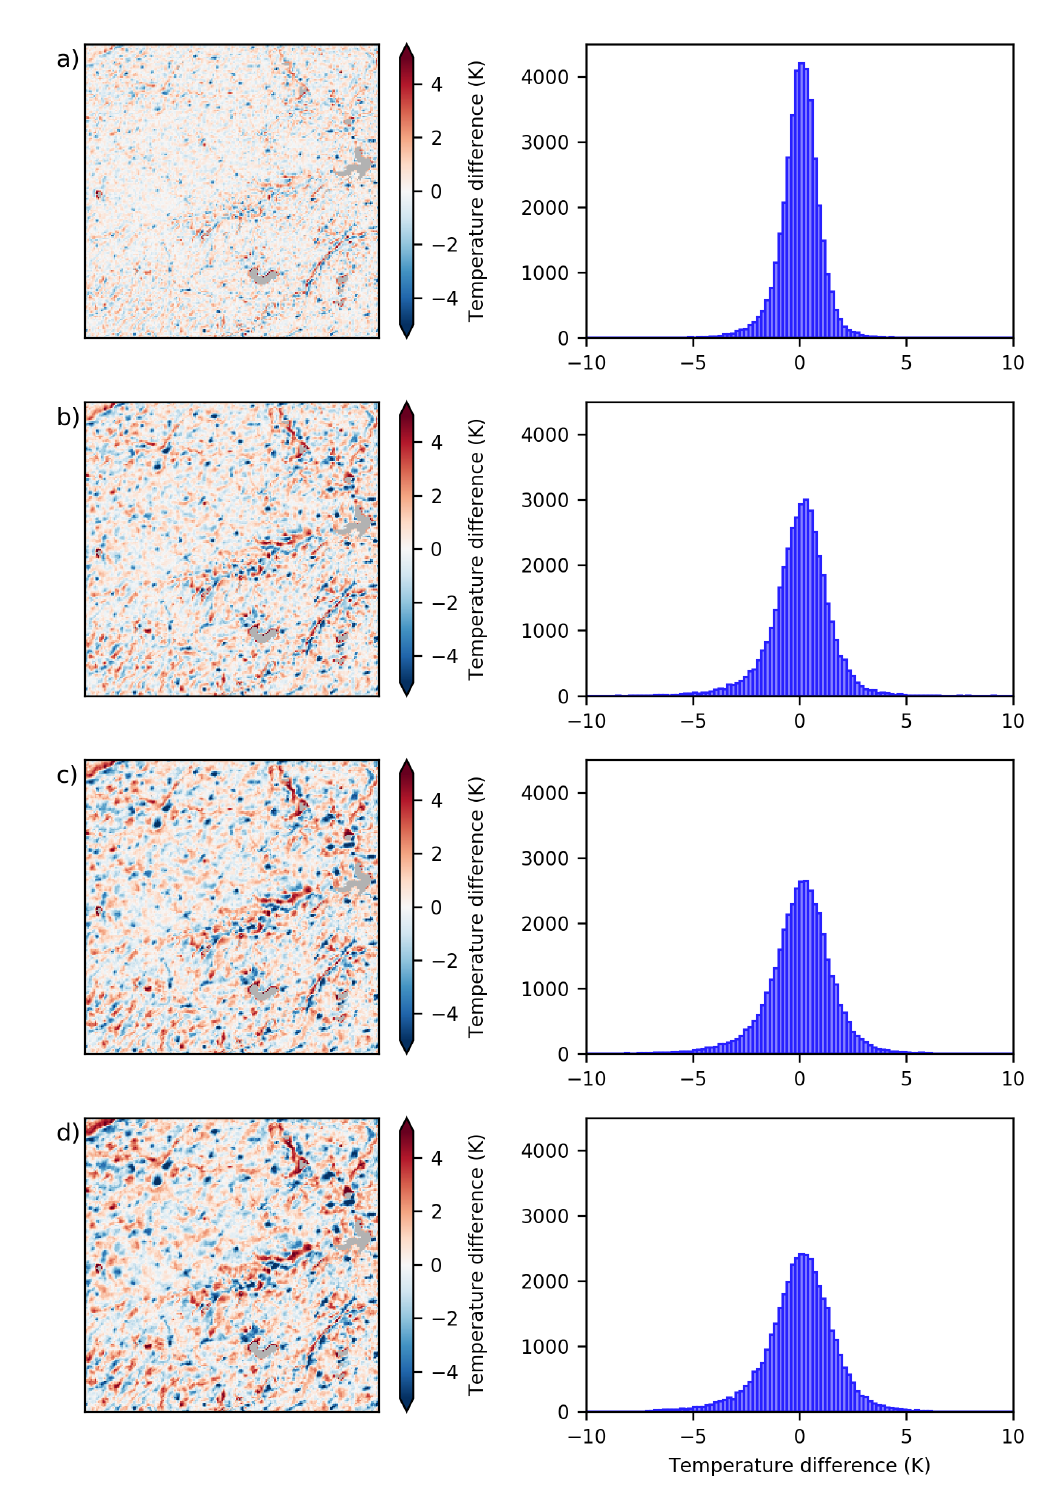
Figure A2. Changes in the spatial and statistical distribution of temperature estimates for the eastern China (chn) study area by window size. Window levels shown are ( a ) 5 × 5 window; ( b ) 7 × 7 window; ( c ) 9 × 9 window; and ( d ) 11 × 11